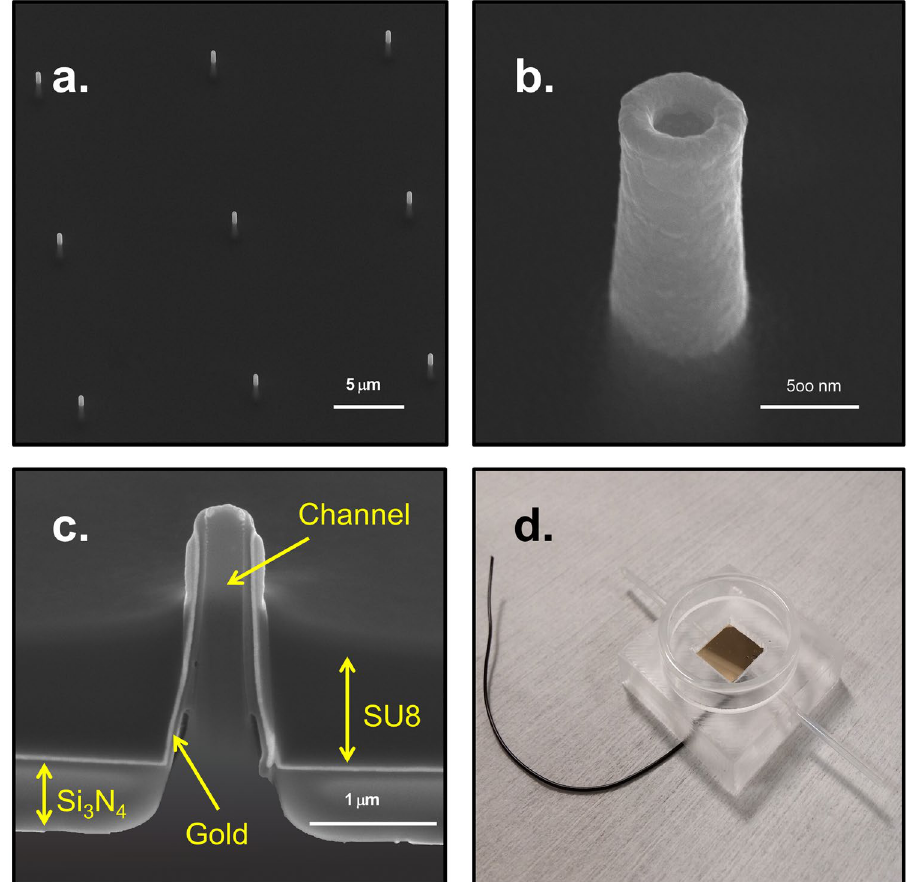
Figure 2. ( a – c ) SEM images of the 3D hollow nanoelectrodes embedded in the epoxy polymer SU8. Respectively, 3 × 3 array of nanoelectrodes, single nanoelectrode and cross section of a single hollow nanoelectrode. The different layers are indicated by the yellow arrows. ( d ) Top view of the PDMS microfluidic chamber. The wire is coming out from the PDMS being bonded by silver paste with the gold spattered onto the device making all the nanoelectrodes connected together. The glass ring around the device allows the cell culture on to the nanofluidic